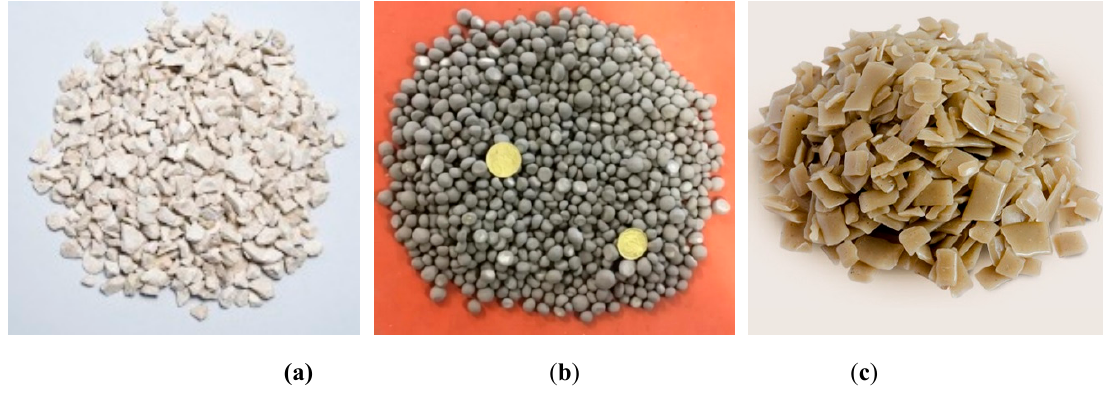
Figure 2. Pale limestone aggregates ( a ), synthetic aggregates ( b ) and transparent polymeric binder ( c ).